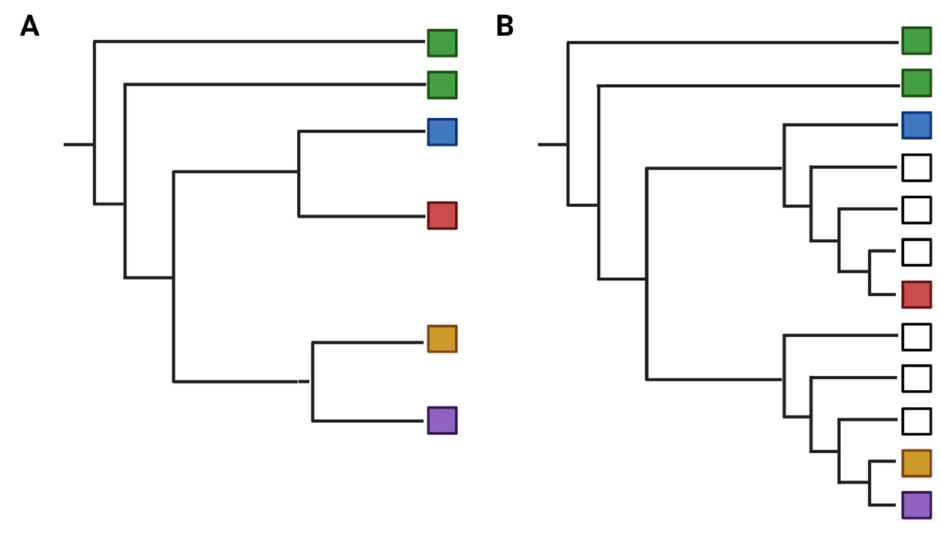
Figure 2. Illustration of how the number of sequences used to build a phylogeny affects the inferred degree of closeness of relationships between taxa. Sister taxa or groups are those that are most closely related to each other and share a unique common ancestor [190]. However, this relationship is sampling-dependent, as shown in the figure. In ( A ), the red and blue taxa are hypothesized to be sister taxa, as are the gold and purple, since they are the closest to each other and share a unique common ancestor. In ( B ), when six new sequences are added to the phylogeny, the gold and purple are still sister taxa; although the red and blue are still in the same clade, they are no longer sister but now appear more distantly related to one another.